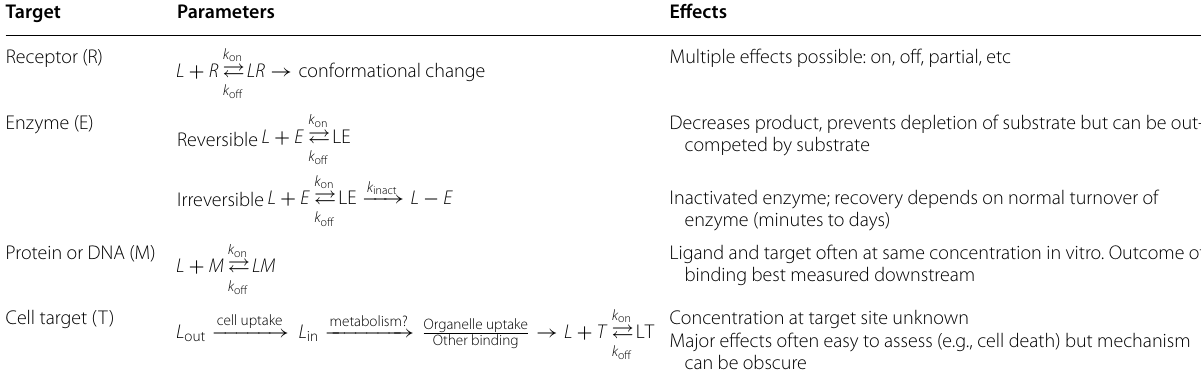
Table 2 Increasing complexity of measurements for assessing new compounds in